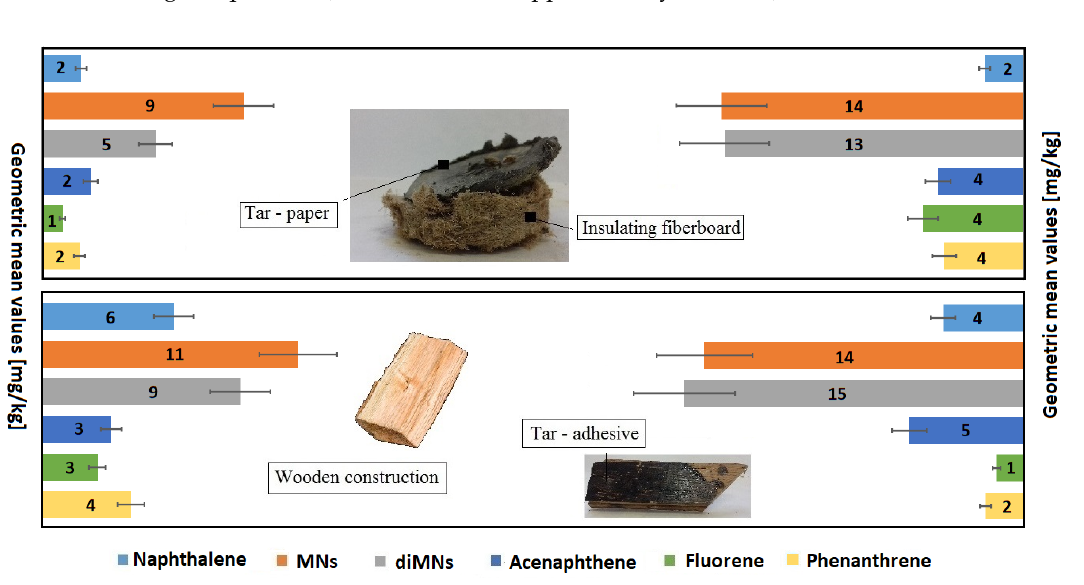
Figure 6. Emission of heterocyclic aromatic hydrocarbons, organochlorine derivatives, and phenolic compounds from samples of construction products taken from buildings intended for human habitation, where complaints about unacceptable hygienic conditions were raised. The results for tar adhesives are not shown in Figure 6, because this group only emits PAH compounds, which originate from poorly cleaned asphalt. Tar adhesives do not emit heterocyclic, Cl-VOCs, and phenolic compounds. CN and cresols, which were identified in small quantities, are secondary contaminants originating in neighboring floor construction materials containing Xylamite. Increasing the temperature increases the molecules’ speed. Higher temperatures usually result in higher diffusion and thus emissions [49,50]. The chemical emission for some Cl-VOCs was measured at a series of temperatures spanning from 80 to 130 °C, so at temperatures well in excess of room temperature. This test allowed the desorption of the greatest amount of compounds from the